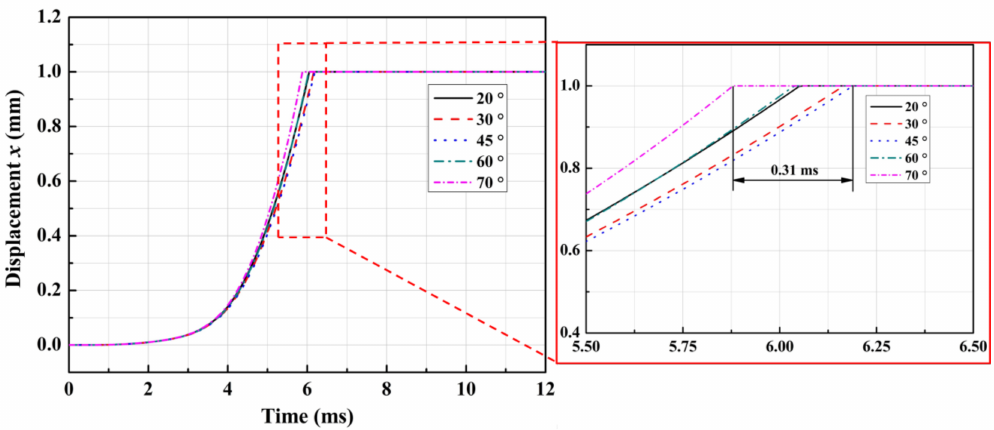
Figure 8. Dynamic response curves under different half cone angle ( P s = 8 MPa, u = 240